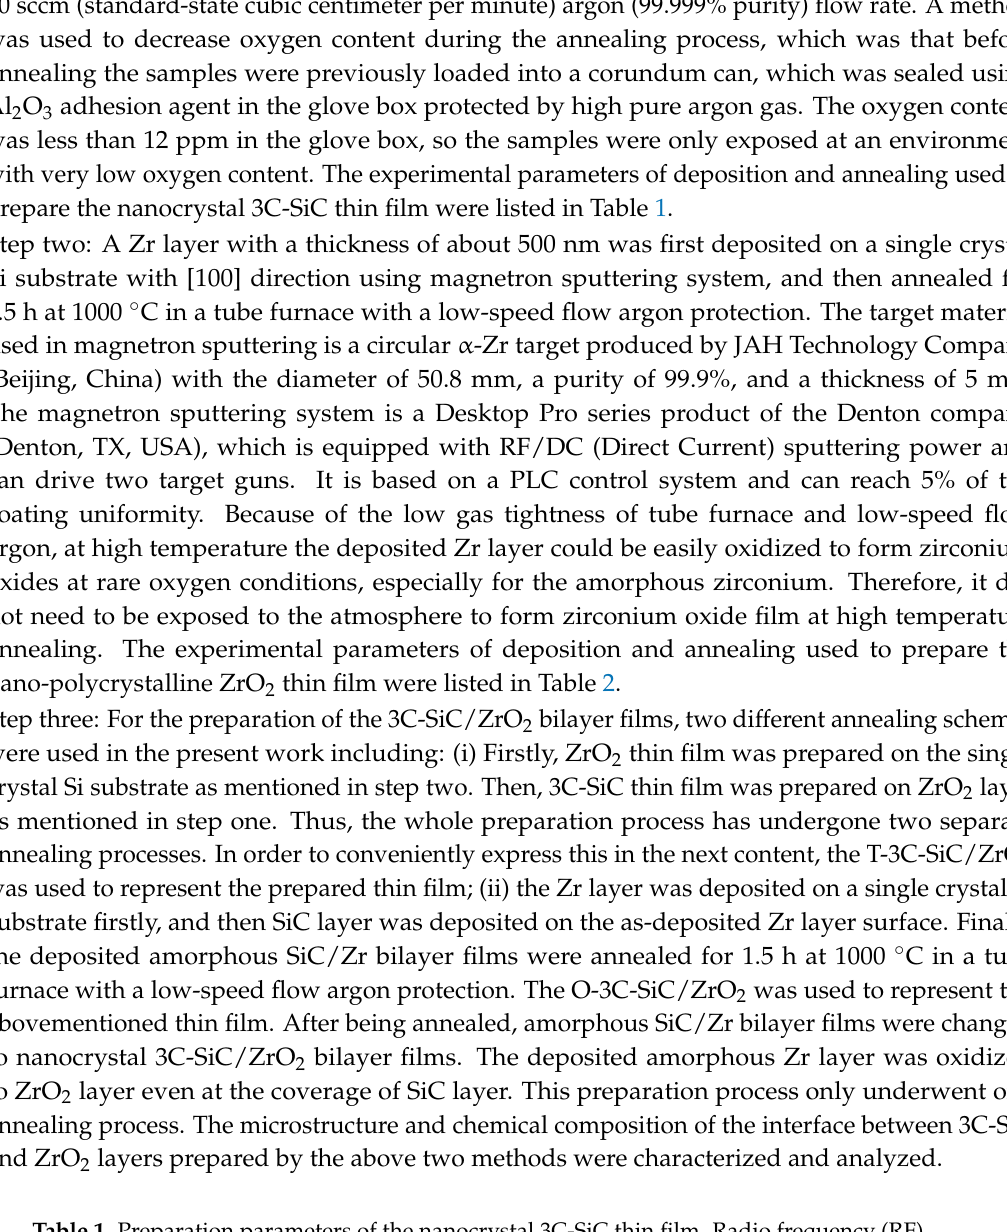
Table 1. Preparation parameters of the nanocrystal 3C-SiC thin film. Radio frequency (RF). Code